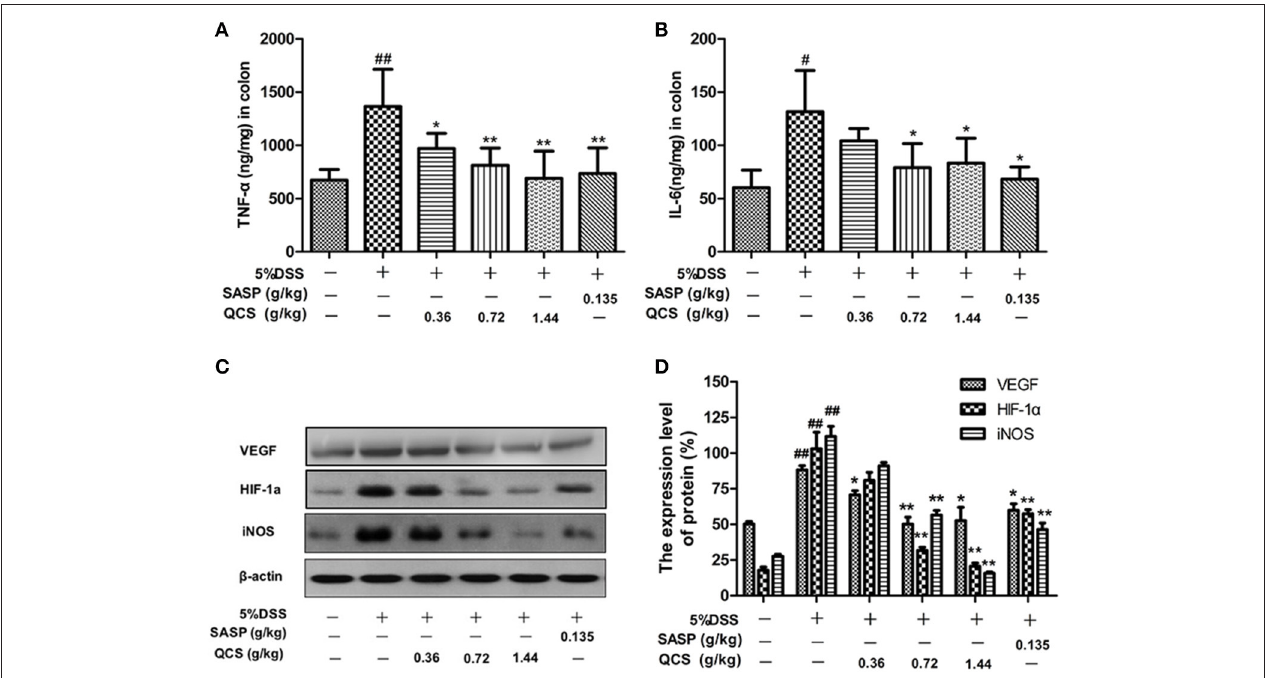
FIGURE 8 | Effects of QCS on DSS-induced production of TNF- α and IL-6 and expression of VEGF, HIF-1 α and iNOS in colonic tissue. (A) Concentration of TNF- α in colonic tissue; (B) concentration of IL-6 in colonic tissue. (C,D) Protein expression of VEGF, HIF-1 α , and iNOS. β -Actin levels were used as loading controls. Results are expressed as mean ± SD ; n = 5, * P < 0.05; ** P < 0.01, vs. model group; # P < 0.05; ## P < 0.01, vs. control